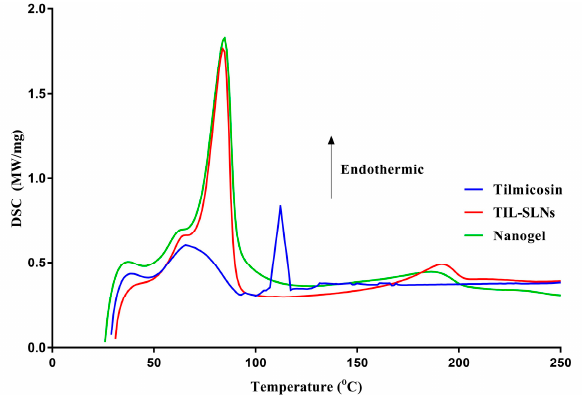
Figure 3. The differential scanning calorimeter (DSC) thermograms of pure tilmicosin, TIL-SLNs and Figure 3. The di ff erential scanning calorimeter (DSC) thermograms of pure tilmicosin, TIL-SLNs TIL-nanogel. and